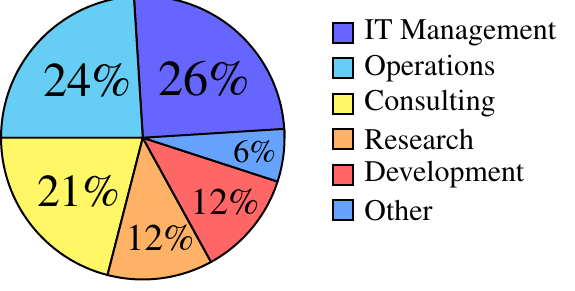
Figure A3. Work departments of participants (n = 34).